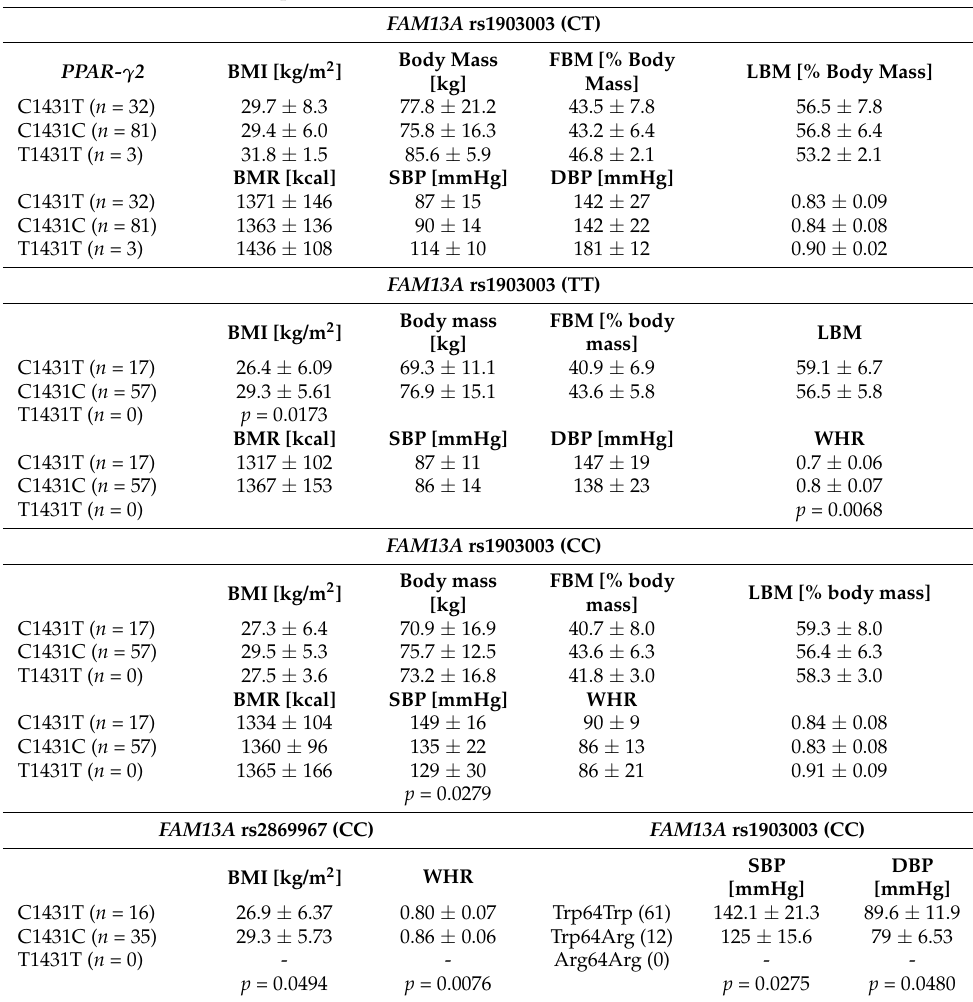
Table 3. Anthropometric and blood pressure analysis [expressed as Mean ± SD] in patients with co-existing genotypes of FAM13A (rs1903003, rs7671167, rs2869967) with PPAR γ -2 gene genotypes (rs3856806, C1431T) prevalence. Anthropometric and Blood Pressure Parameters [Mean ± SD] FAM13A rs1903003 (CT) Body Mass PPAR- γ 2 BMI [kg/m 2 ]